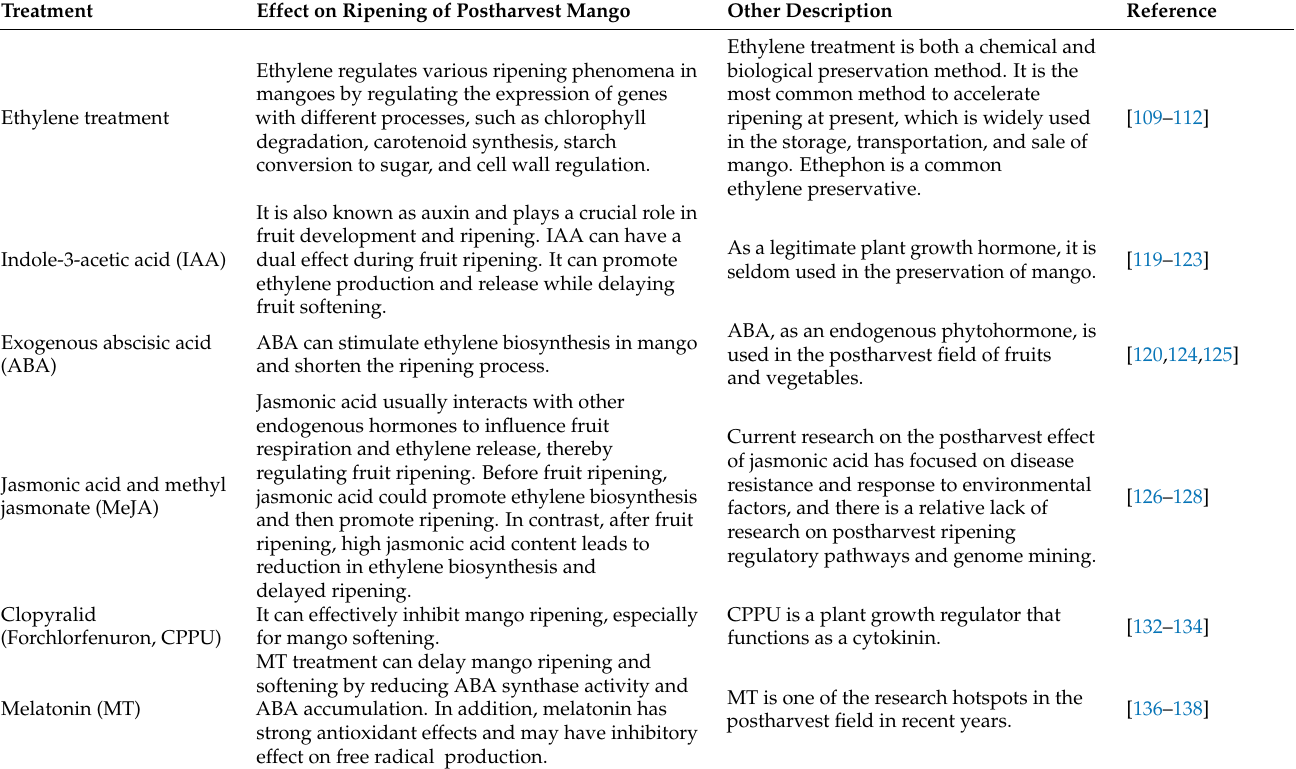
Table 3. Effects and comparison of different biological treatments on postharvest mango